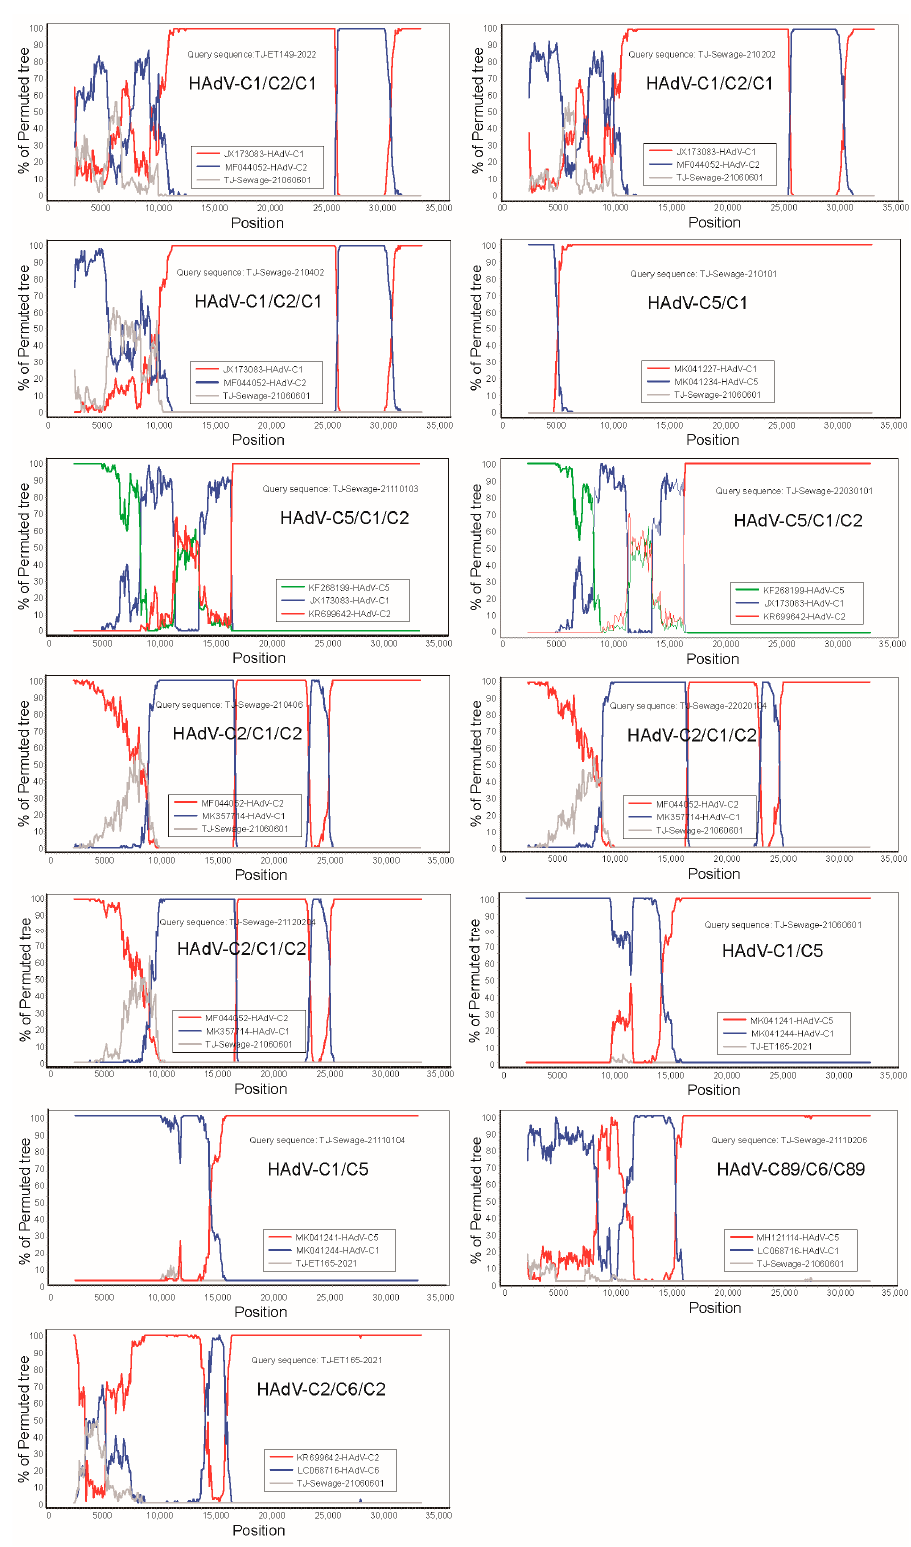
Figure 4. Bootscanning analysis of the 13 Tianjin HAdV-C genomes using a sliding window of 200 nt moving in 20-nt steps. For each bootscanning analysis, the names of viruses of the query sequence were indicated in the plot.